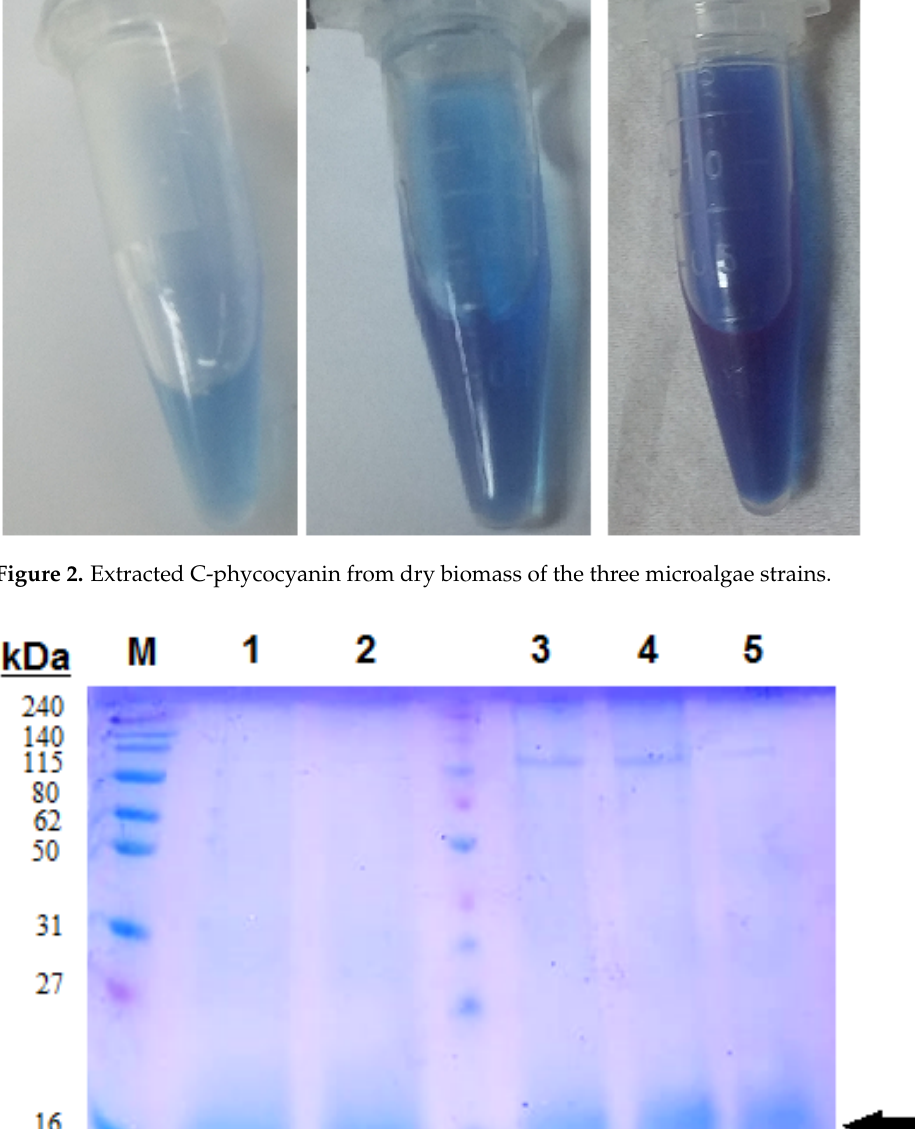
Figure 4. Visible spectrum (at wavelengths 600–650 nm) of the extracted C-phycocyanin from dry biomass of the three microalgae strains. Table 2. The concentration and purity of the extracted C-phycocyanin from dried biomass of the three microalgae strains. Strain